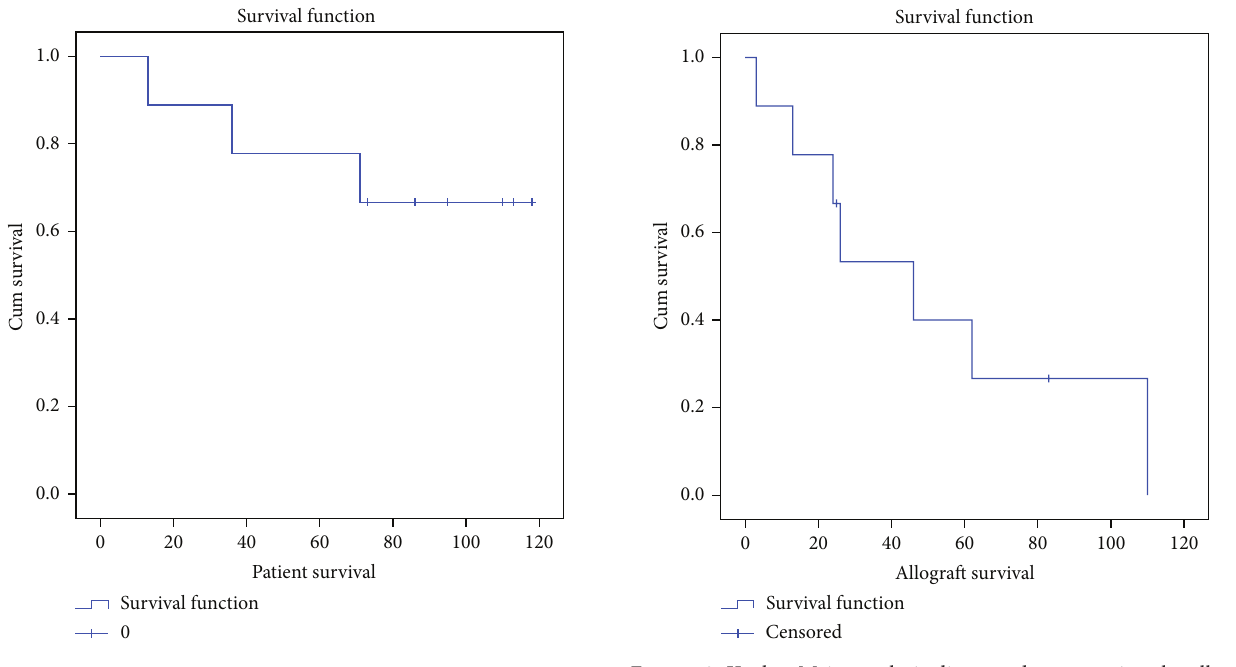
Figure 2: Kaplan-Meier analysis diagram demonstrating the overall cumulative survival of the patients.